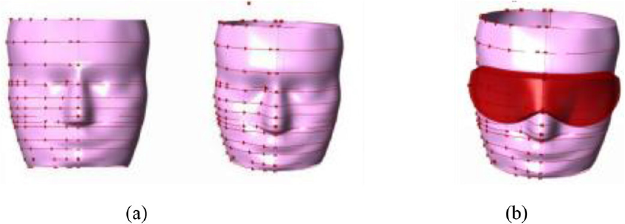
Fig. 17. Parameterization of the user ’ s head and a diagram of the